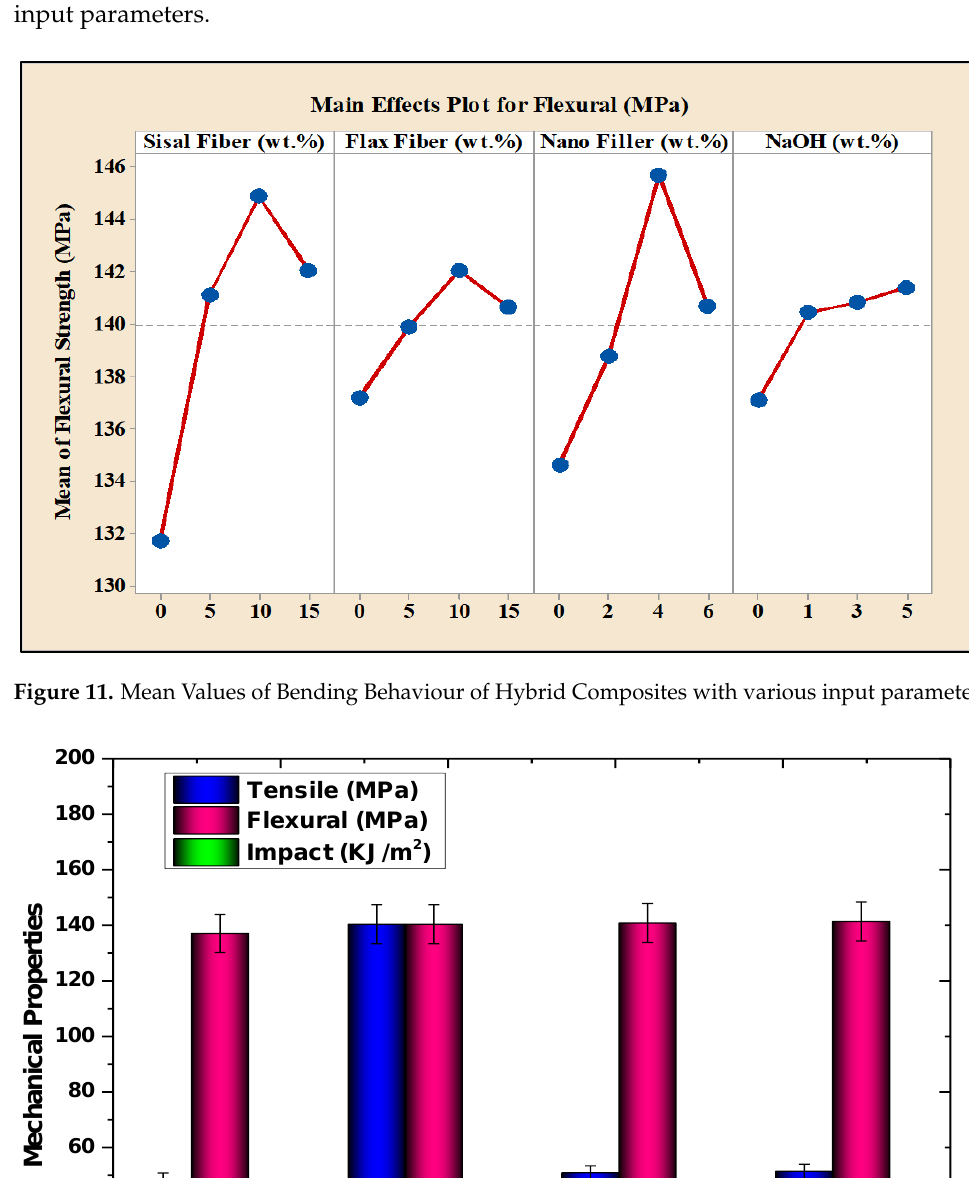
Figure 13. Mean Values of Impact Behaviour of Hybrid Composites with various input parame- ters.